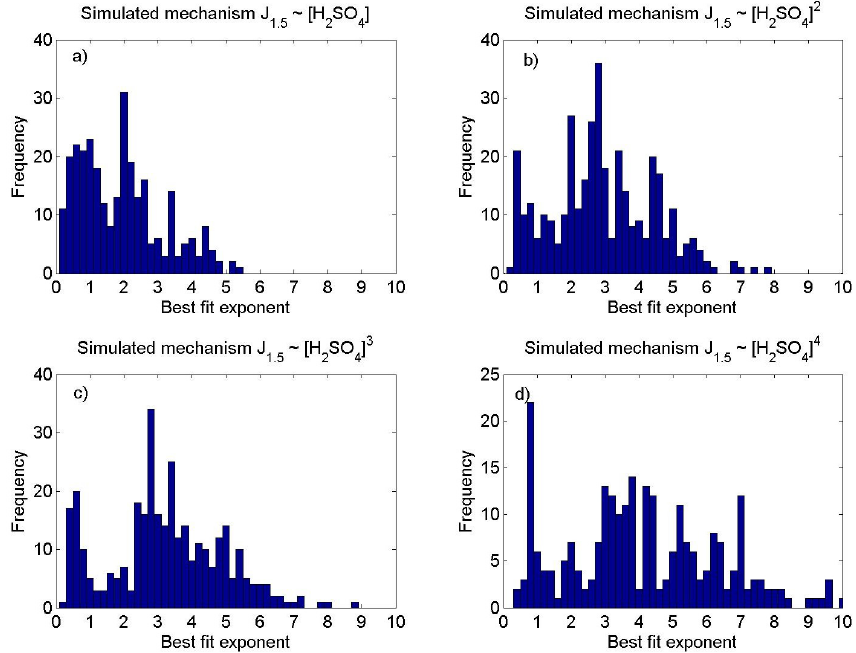
Fig. 5. The frequency distribution of best fit exponents for J 1 . 5 ∼ [H 2 SO 4 ] b for the four nucleation mechanisms: (a) J 1 . 5 ∼ [H 2 SO 4 ] (activation nucleation), (b) J 1 . 5 ∼ [H 2 SO 4 ] 2 (kinetic nucleation), (c) J 1 . 5 ∼ [H 2 SO 4 ] 3 , and (d) J 1 . 5 ∼ [H 2 SO 4 ] 4 . Note that only b = [0.1, 10] was